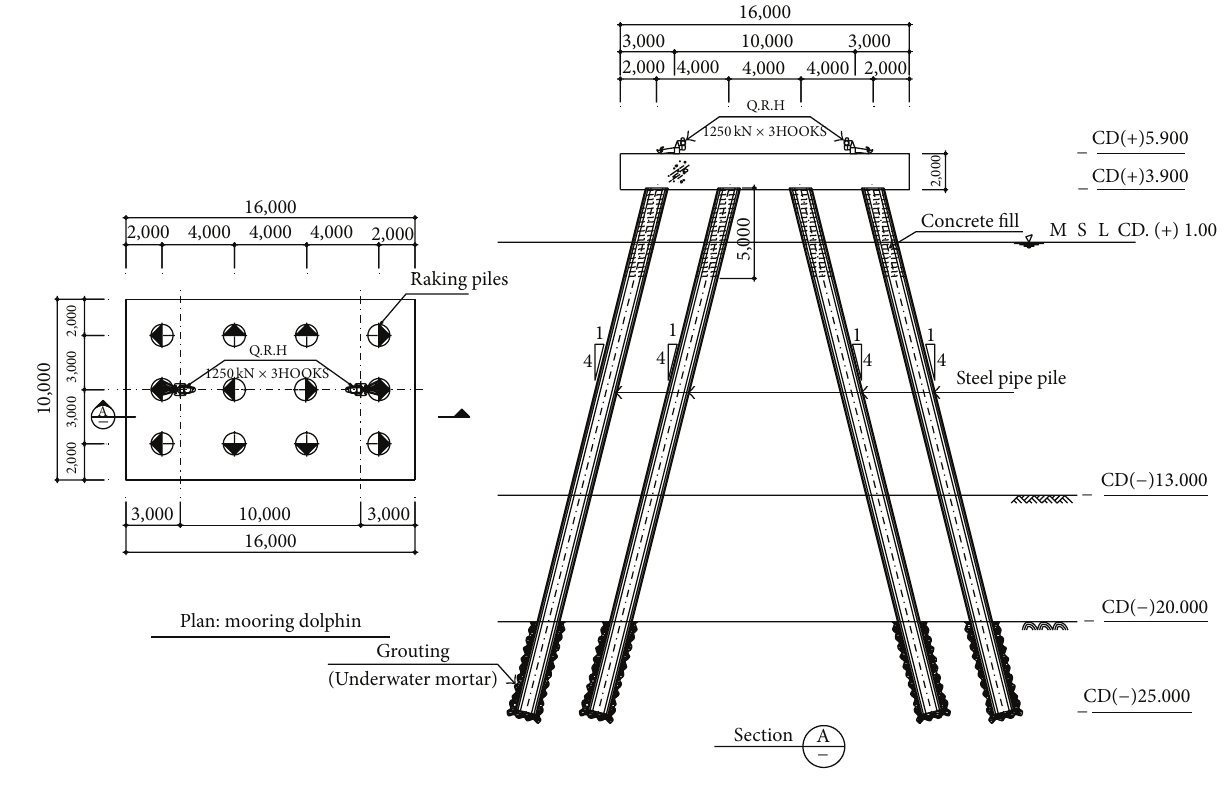
Figure 3: Mooring dolphin for U-project.